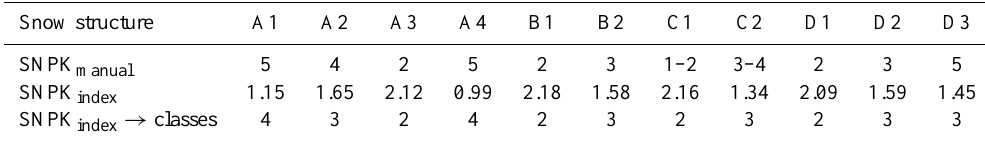
Table 6. Comparison of 11 simplified, typical profile types by manual snowpack structure classification SNPK manual , the calculated SNPK index and the classes derived from SNPK index for profiles shown in Fig. 3.